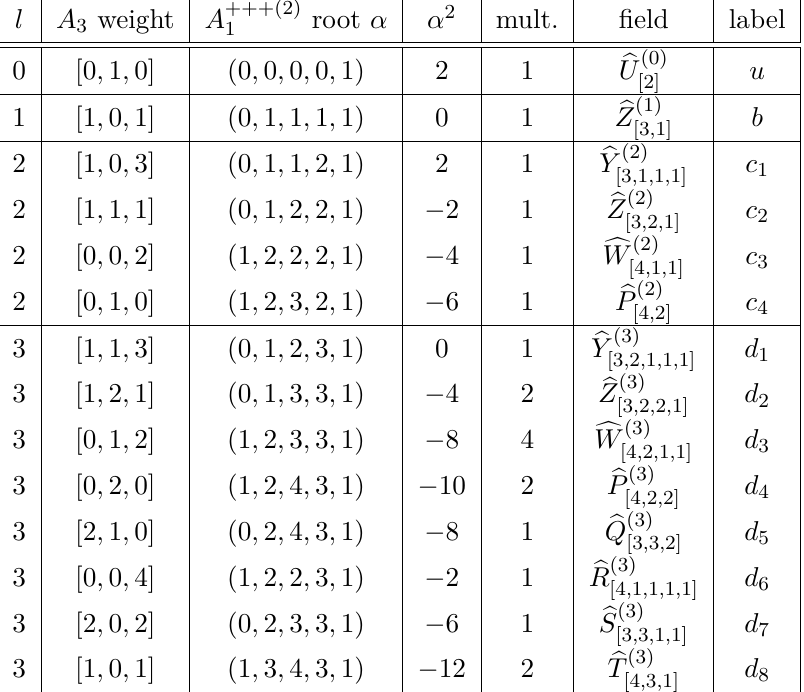
Table 2 . The ‘ 2 representation of A +++